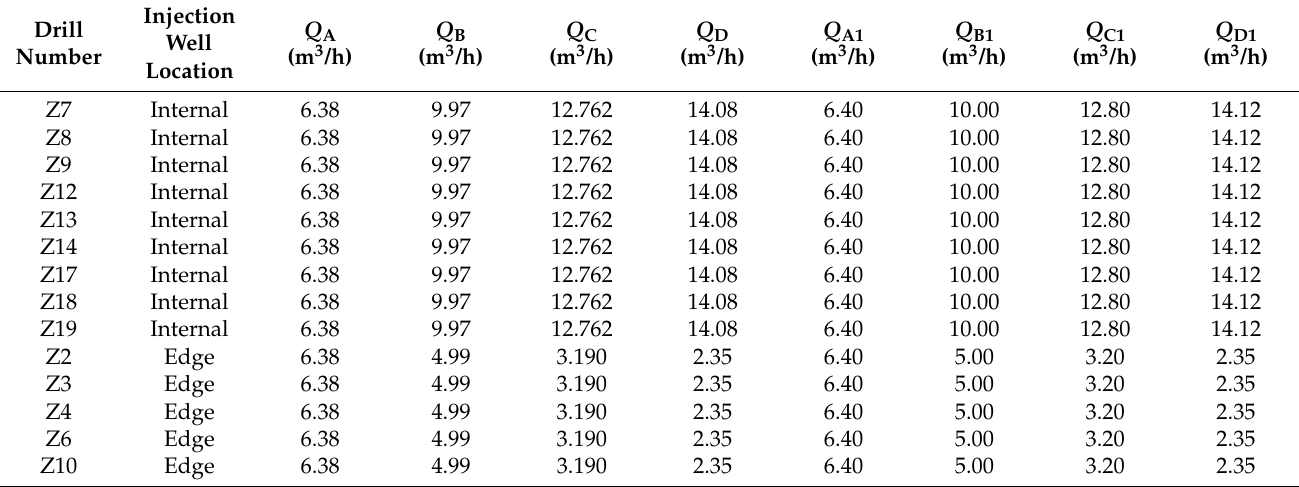
Table 2. Flow distribution table of injection wells at different positions.